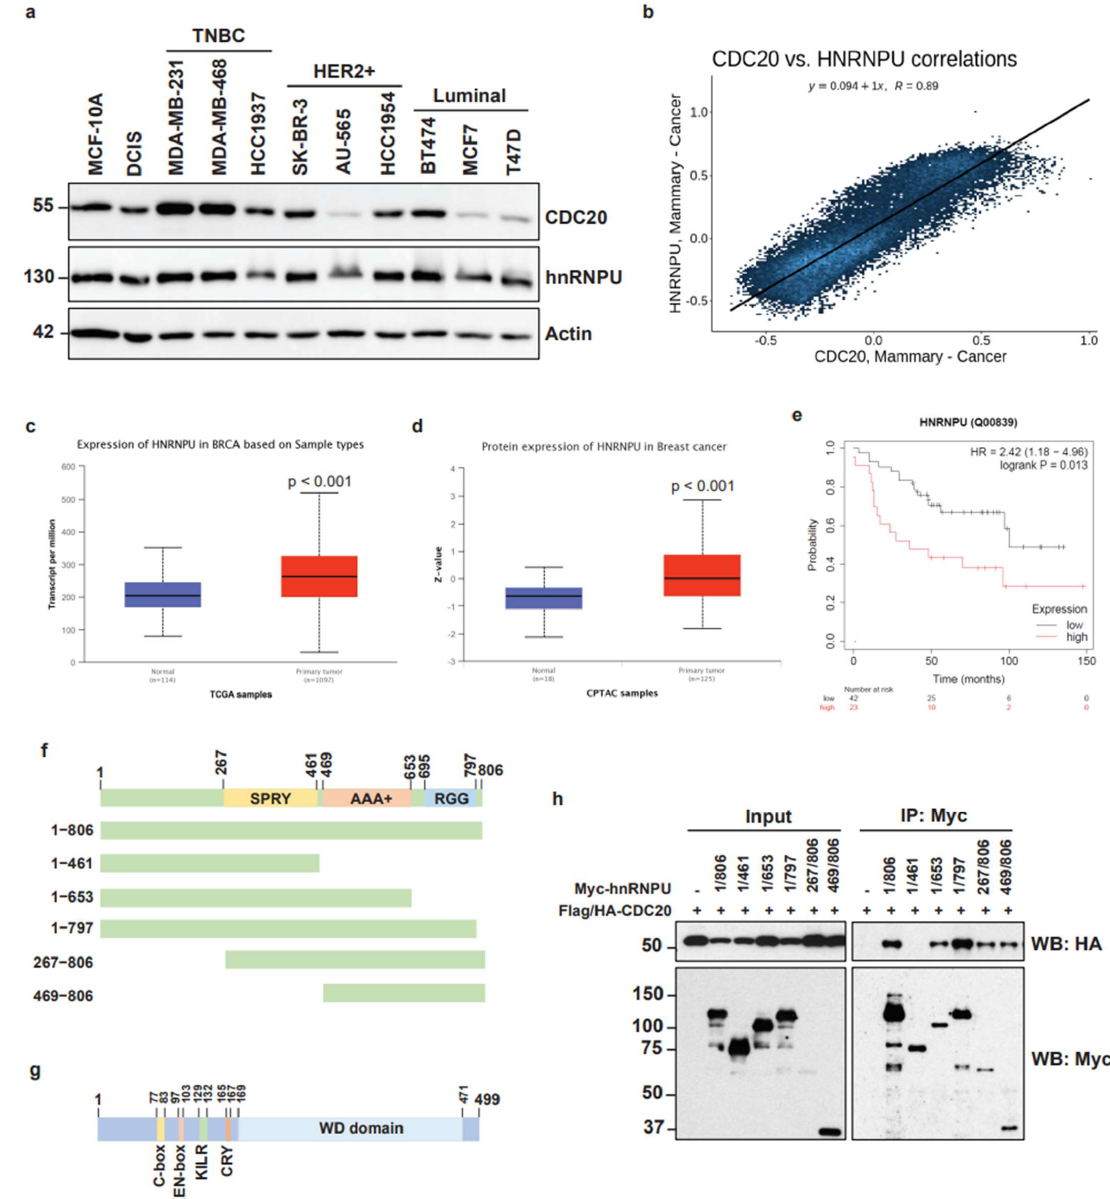
Figure 4. High expression of hnRNPU in breast cancer and mapping of molecular interaction between CDC20 and hnRNPU. ( a ) The expression of hnRNPU was analyzed by Western blot in the normal breast epithelial cell line (MCF-10A), the ductal carcinoma in situ (DCIS) cell line, and different breast cancer cell lines. ( b ) The correlation between CDC20 and hnRNPU expression in breast cancer patients was analyzed by using correlationAnalyzerR. ( c ) Box plots showing relative expression of hnRNPU mRNA in human breast cancer and normal tissues. ( d ) Box plots showing relative expression of hnRNPU protein in human breast cancer and normal tissues. The transcriptome and proteome data were obtained from TCGA and CPTAC databases, respectively, and box plots were generated using the UALCAN web resource. ( e ) Kaplan–Meier overall survival (OS) curves of breast cancer patients with high and low hnRNPU expression levels. ( f ) Schematic representation of human hnRNPU with previously identified domains and deletion constructs. ( g ) Schematic representation of human CDC20 with previously identified domains. ( h ) 293T cells were transfected with equal amounts of the indicated plasmids. After transfection for 48 h, cells were harvested, and the cell lysates were immunoprecipitated with an anti-Myc antibody. Immunoblot analysis revealed that the amino acid region 461–653 on hnRNPU is required for its interaction with